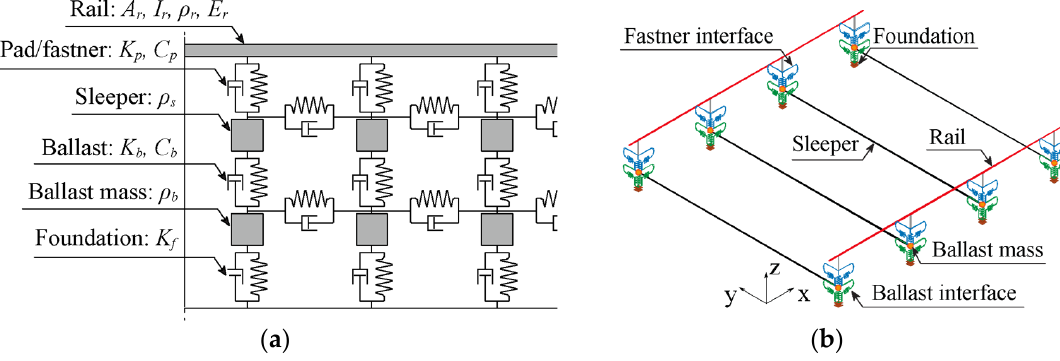
Figure 2. Numerical model of the track: ( a ) multi-layer representation and ( b ) FE model. Table 2. Stiffness properties of the railway track.